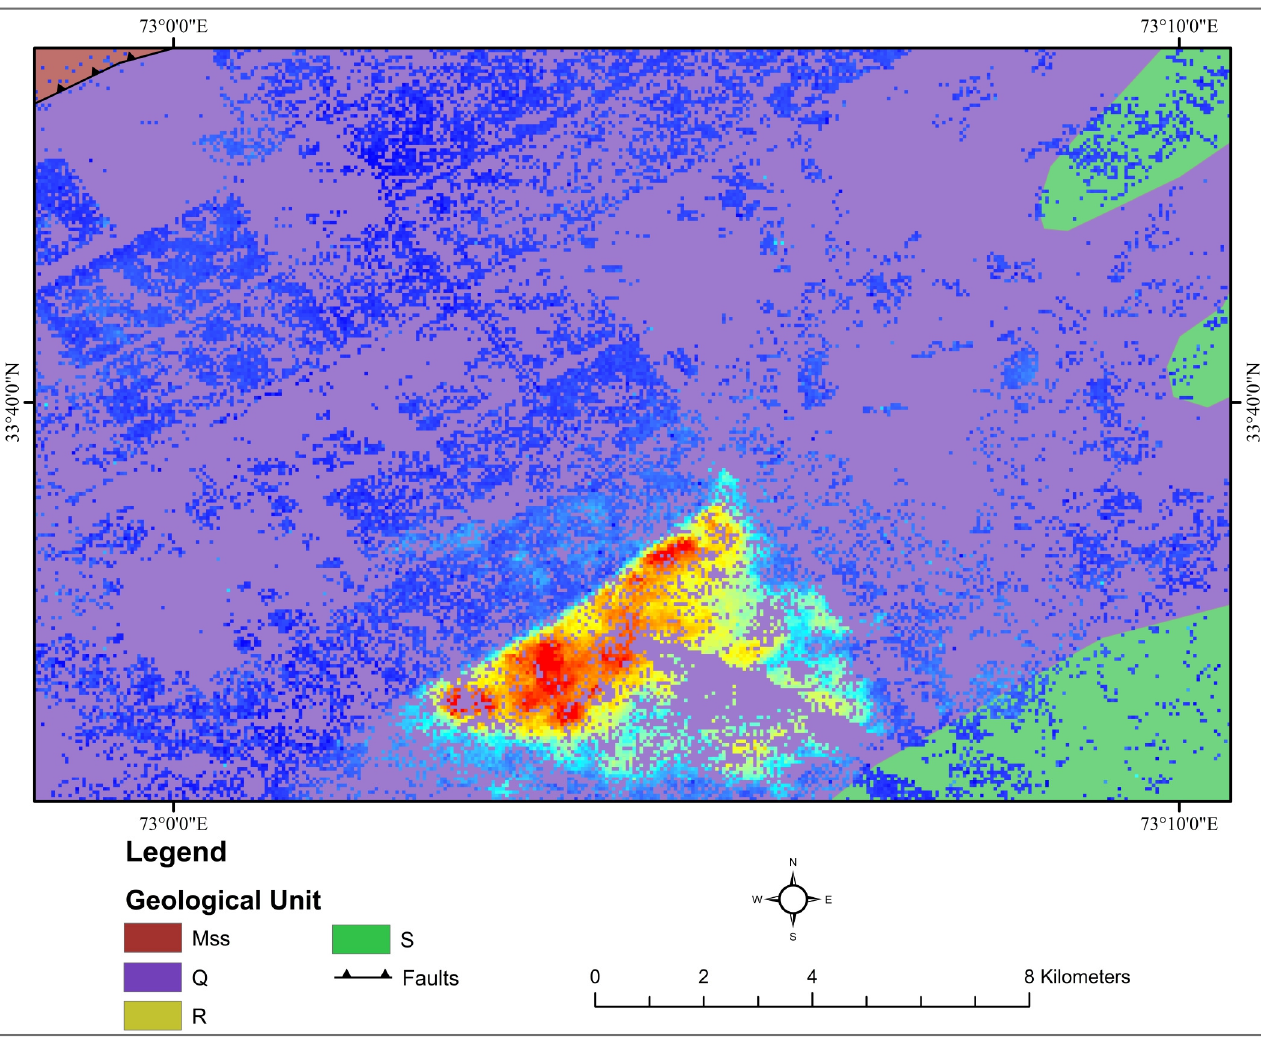
Figure 20. Subsidence along the geological map in the research area.